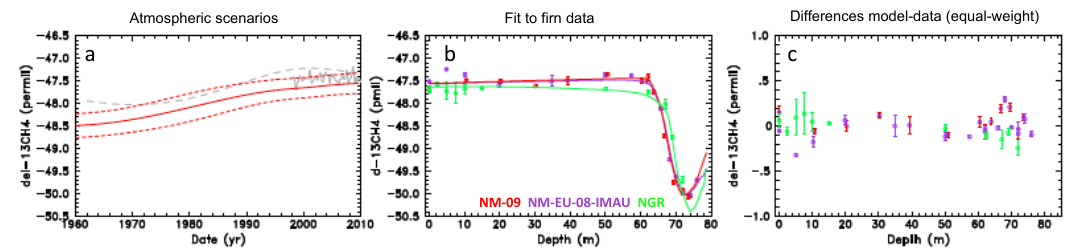
Fig. 8. NH Multi-site δ 13 C(CH 4 ) trend scenarios based on Kr corrected firn data. (a) Note that here NGR data are data measured at IMAU with lower depth resolution than previously shown, because the NGRIP data from LGGE could not be corrected for the Kr interference. (b) the fit to the firn data and (c) model-data differences. The continuous grey curve (a) represents continuous atmospheric monitoring data from the NOAA-ESRL network. The dashed grey curve shows the preferred multi-site scenario based on non Kr-corrected data (red continuous line in Fig.5a).